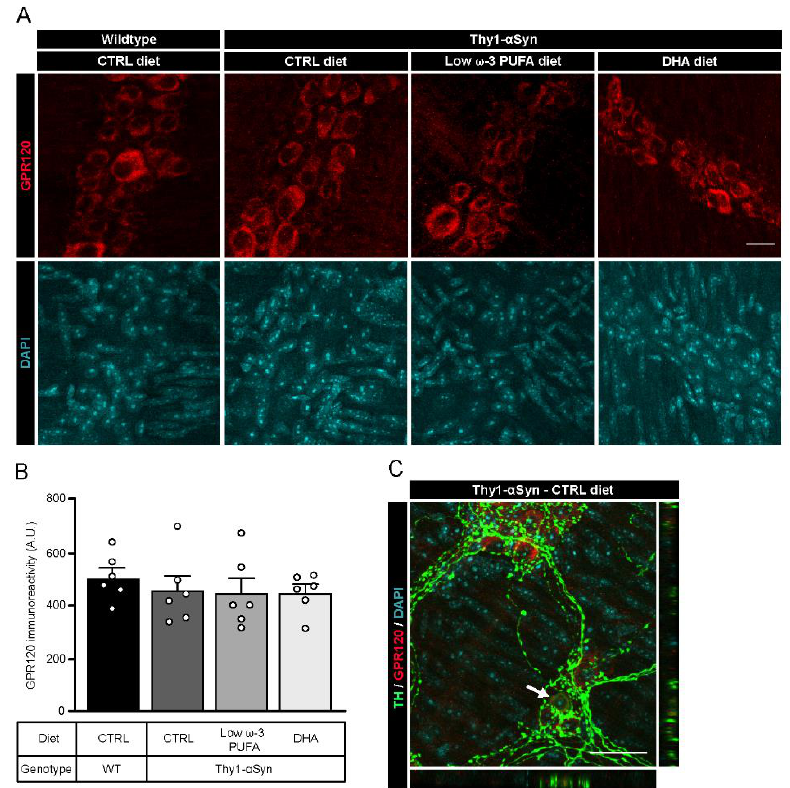
Figure 3. Localization of the DHA receptor GPR120 in the murine myenteric plexus. ( A ) Photomicro- graphs of enteric GPR120 immunofluorescence (red) in wild-type and Thy1- α Syn mice maintained on different diets. Scale bar = 15 µ m. ( B ) Quantification of GPR120 by immunoreactivity shows no difference between animals or among dietary groups (one-way ANOVA: p = 0.7613). ( C ) Photomicrographs of the myenteric plexus from Thy1-αSyn mice on control diet showing GPR120 (red) and TH + neurons (green) reveal colocalization between the receptor GPR120 and TH + neuronal body in the enteric nervous system, as indicated by the white arrow. Scale bar = 30 µ m. Abbreviations: A.U., arbitrary unit; CTRL, control; DHA, docosahexaenoic acid; GPR120, G-protein coupled receptor 120; TH, tyrosine hydroxylase; WT, wild-type. (white dots) show an increase of varicosities per 100 µ m of dendrites in transgenic mice fed with DHA-enriched diet compared to control diet.